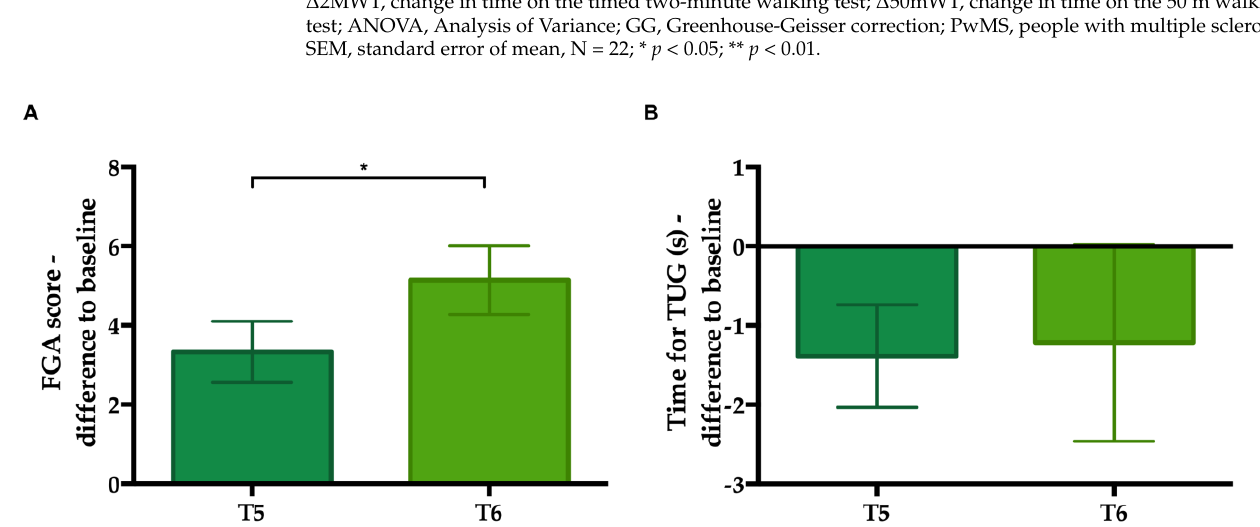
Figure 3. Gait measures for all PwMS pooled. ( A ) Change in functional gait assessment (FGA) scores at T5 and T6 relative to baseline. ( B ) Change in time for the timed-up and go (TUG) at T5 and T6 relative to baseline. ( C ) Distance walked in 2 min at T0, T5, and T6. ( D ) Time taken to complete the 50 m overground walking test at T0, T5, and T6. Note. Error bars represent the standard error of the mean. * p < 0.05; ** p < 0.01. Table 4. Repeated measures ANOVA examining the effect of session on FGA scores, time on the TUG and 50mWT, and distance on the 2MWT at T0, T5, and T6 (upper part of the table). Paired- samples t -tests examining the changes from baseline in FGA score, time on the TUG and 50mWT, and distance on the 2MWT (difference between T5 and T6; lower part of the table). Pooled data across all PwMS.